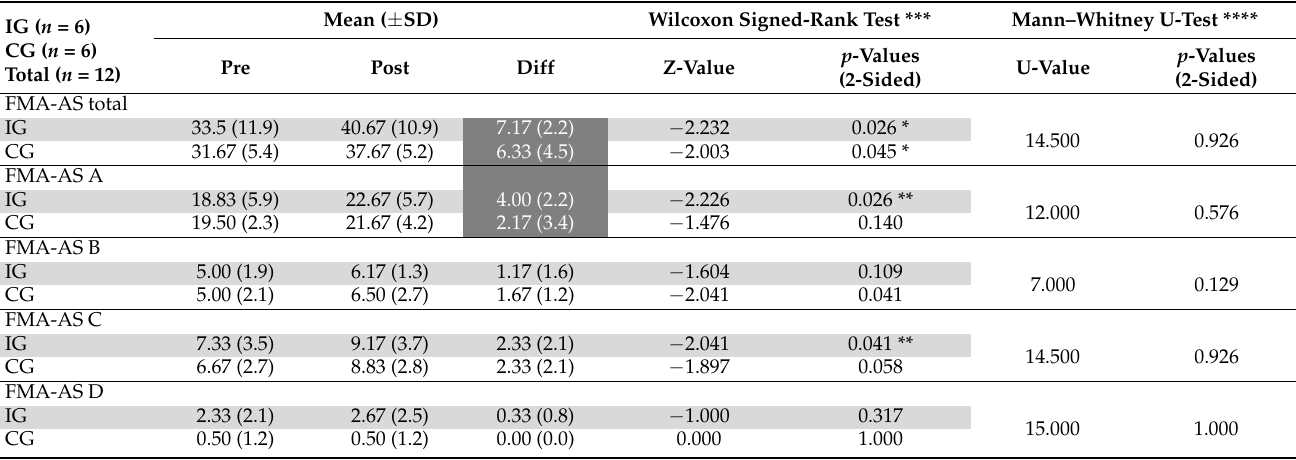
Table 2. Descriptive results (mean ± standard deviation, SD) of the Fugl-Meyer Assessment Arm Section (FMA-AS) total score and scores on the subscales A, B, C, D.